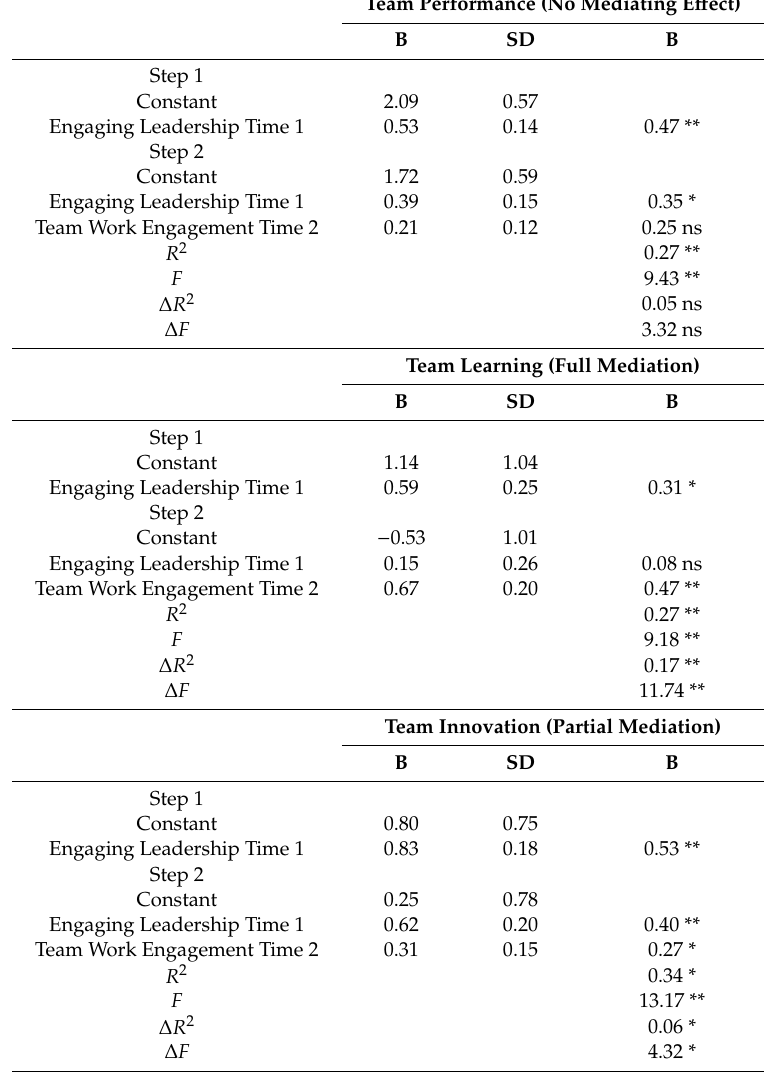
Table 4. The Results of Ordinary Least Squares (OLS) Regression of Team Outcomes (N =